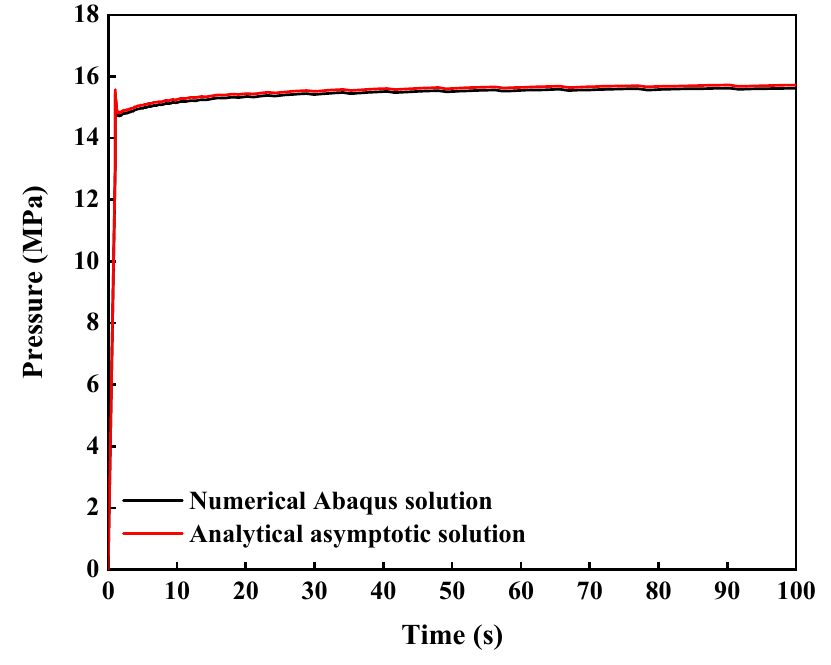
Figure 20. Time evolution of pressure near the injection point (K vertex).